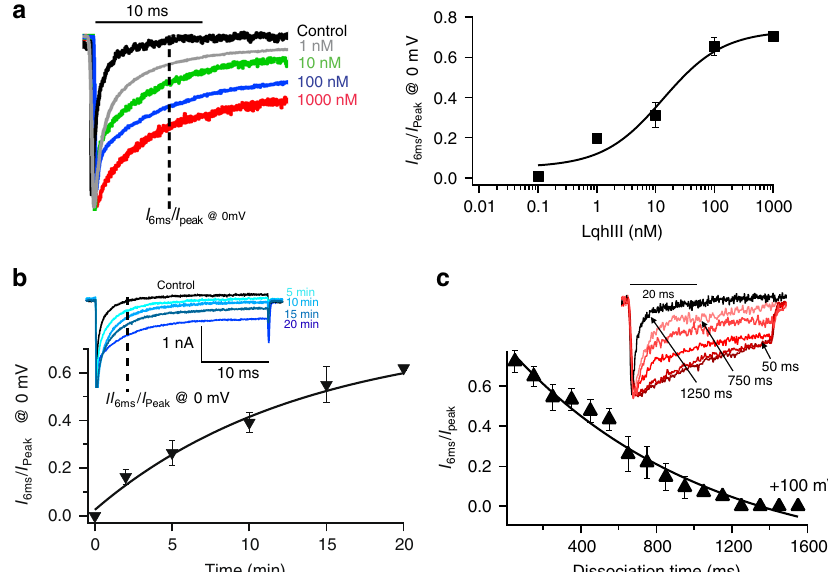
Fig. 1 Block of fast inactivation of rNa V 1.5 C by LqhIII. a Left . Normalized current traces from HEK293 cells expressing rNa v 1.5c in the absence (black) or in the presence of 1 nM (grey), 10 nM (green), 100 nM (blue), or 1000 nM (red) LqhIII. Cells were held at − 120 mV and Na + currents were elicited with a 1000-ms step to 0 mV. Measurements at different toxin concentrations were carried out on different cells because of the limited stability of the whole-cell recording con fi guration on virus-infected HEK293 cells. Right . Concentration-response curve of LqhIII scorpion toxin for inhibition of fast inactivation of the rNa V 1.5 C channel. Each point is an average of 4 – 5 cells. Data-points and error bars represent mean and s.e.m. The solid line represents the Hill equation fi t to the data. EC 50 = 11.4 ± 0.9 nM (s.e.m., n = 23 cells). b The time course of association of 100 nM of LqhIII scorpion toxin. Cells were held at − 120 mV and the toxin was perfused. A pulse to 0 mV from V m = − 120 mV was applied at the indicated times. Single exponential fi tting of the block of inhibition ratio showed a time constant of 11.3 min. Each point is an average of six cells. Data points and error bars represent mean and s.e.m. c Time course of LqhIII dissociation. A three-pulse protocol was applied: fi rst, a pulse from − 120 mV to + 100 mV for the indicated times, followed by a second 50-ms hyperpolarizing pulse to allow recovery from fast inactivation, and fi nally by the third pulse of 50 ms to 0 mV to measure the extent of recovery of fast inactivation kinetics. Mean and s.e.m.; n = 5 cells for each data point. Inset , representative traces showing recovery of fast inactivation. Source Data are provided as a Source Data